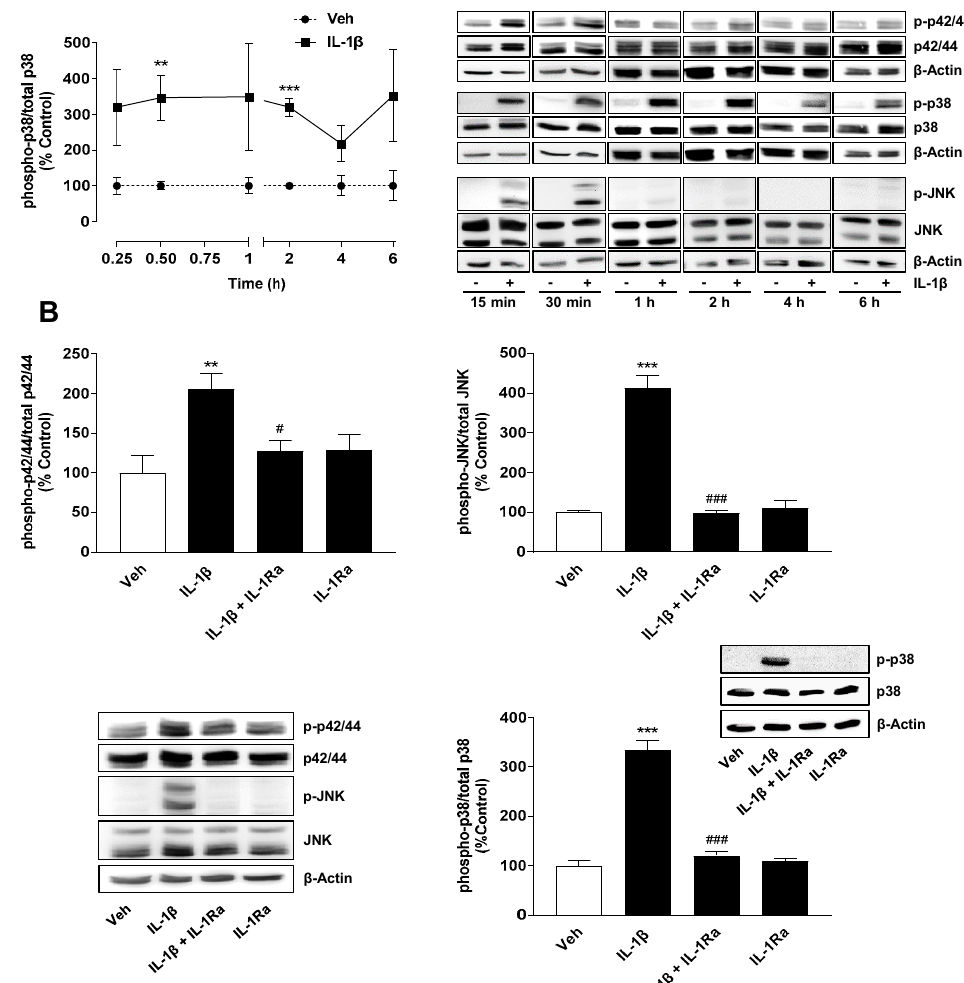
Figure 2. IL-1 receptor-dependent activation of p42/44 MAPK, JNK and p38 MAPK. Time course of IL-1 β -induced activation of p42/44 MAPK, JNK and p38 MAPK ( A ). Effect of IL-1Ra (10 µ g/mL) on IL-1 β -induced or basal p42/44 MAPK, JNK and p38 MAPK activation ( B ). The cells were incubated in the presence or absence of IL-1 β (10 ng/mL) for the specified time periods ( A ) or preincubated with IL-1Ra for 2 h and then coincubated with IL-1 β or vehicle for 30 min ( B ). All percentage values shown refer to the respective vehicle control, which was set to 100%. The values shown in the histograms are based on densitometric analyses of blots, whereby the phosphorylated forms were normalized to the respective total form. In the labelling of the MAPK blots ( A , B ), the prefix “p-” stands for “phospho-”. The blots shown are representative. In ( A ), the same β -actin blots are shown for the 1-, 2-, 4- and 6-h values of the p42/44 and p38 MAPK analyses, because the analyses of the same lanes were shown here as representative blots. The data are mean values ± SEM of n = 4 ( A , B , upper right), n = 7–8 ( B , upper left) or n = 3 ( B , lower right) experiments per group. * p ≤ 0.05, ** p ≤ 0.01, *** p ≤ 0.001 vs. vehicle control; # p ≤ 0.05, ### p ≤ 0.001 vs. IL-1 β ; Student’s t test ( A ) or one-way ANOVA with Bonferroni’s post hoc test ( B ).